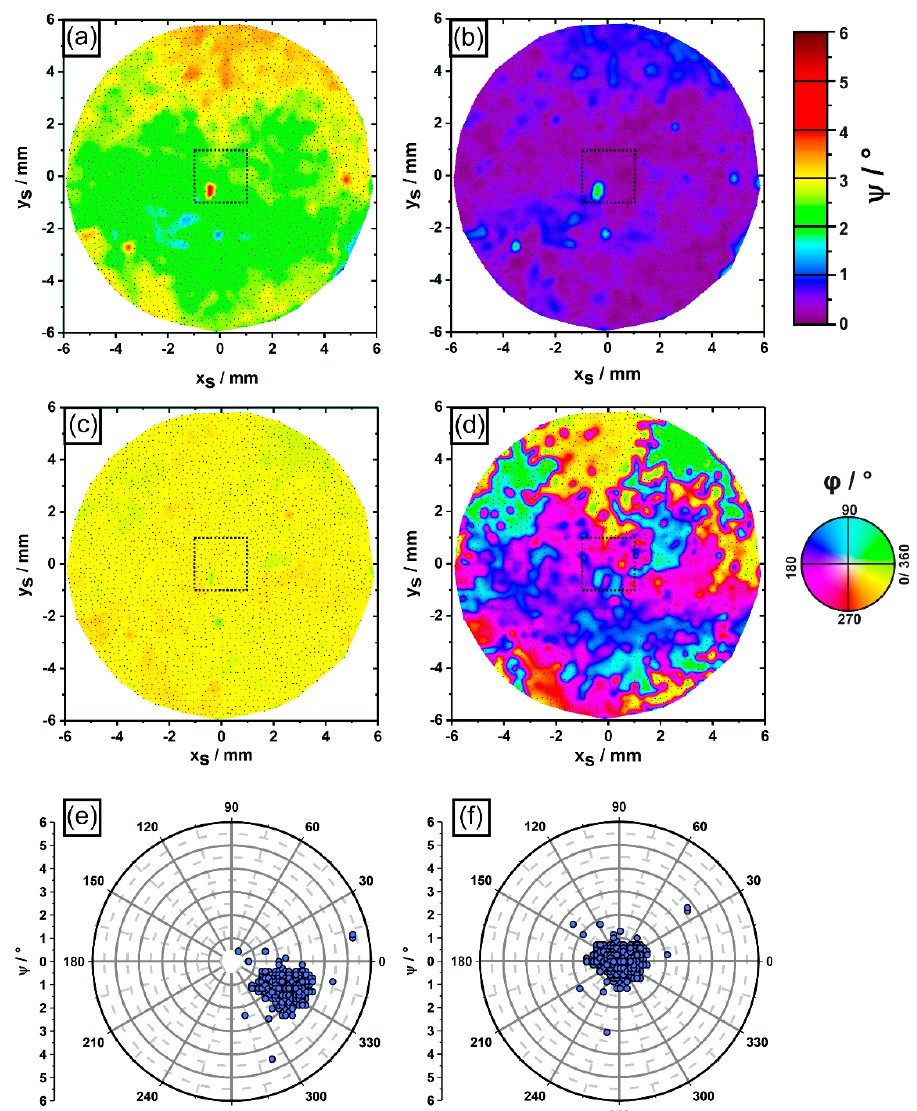
Figure 10. Dendrite orientations/growth directions from whole cross section. ( a – d ) Color-coded maps showing ( a , b ) polar angle and ( c , d ) azimuth angle distributions. The black rectangle indicates the smaller sample region considered in Figures 5, 8 and 9. ( e , f ) Pole figure plots of dendrite growth directions. Sub-figures in left column ( a , c , e ): Raw orientation data. Subfigures in right column ( b , d , f ): dendrite orientations after compensation of average dendrite misorientation.